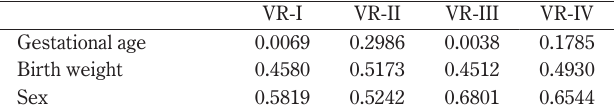
Table 4 Multiple linear regression analysis